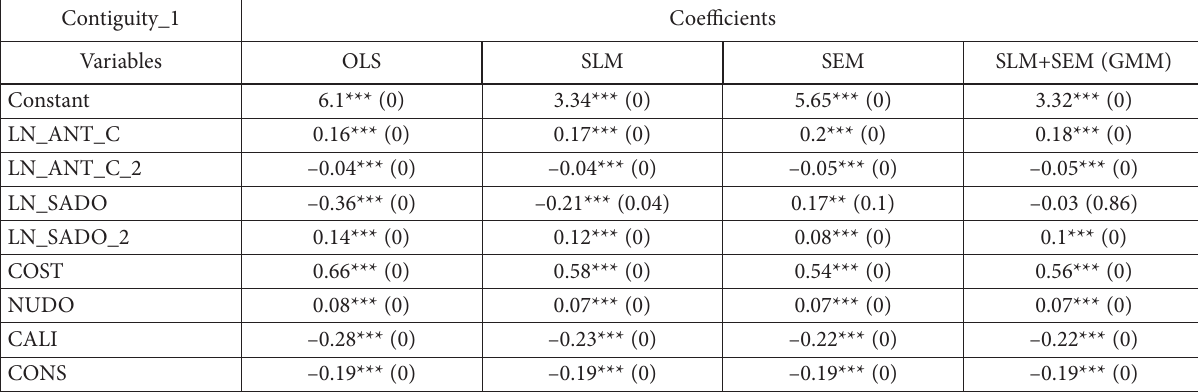
Table 5. Model OLS, models SLM and SEM estimated by ML and model SLM-SEM estimated